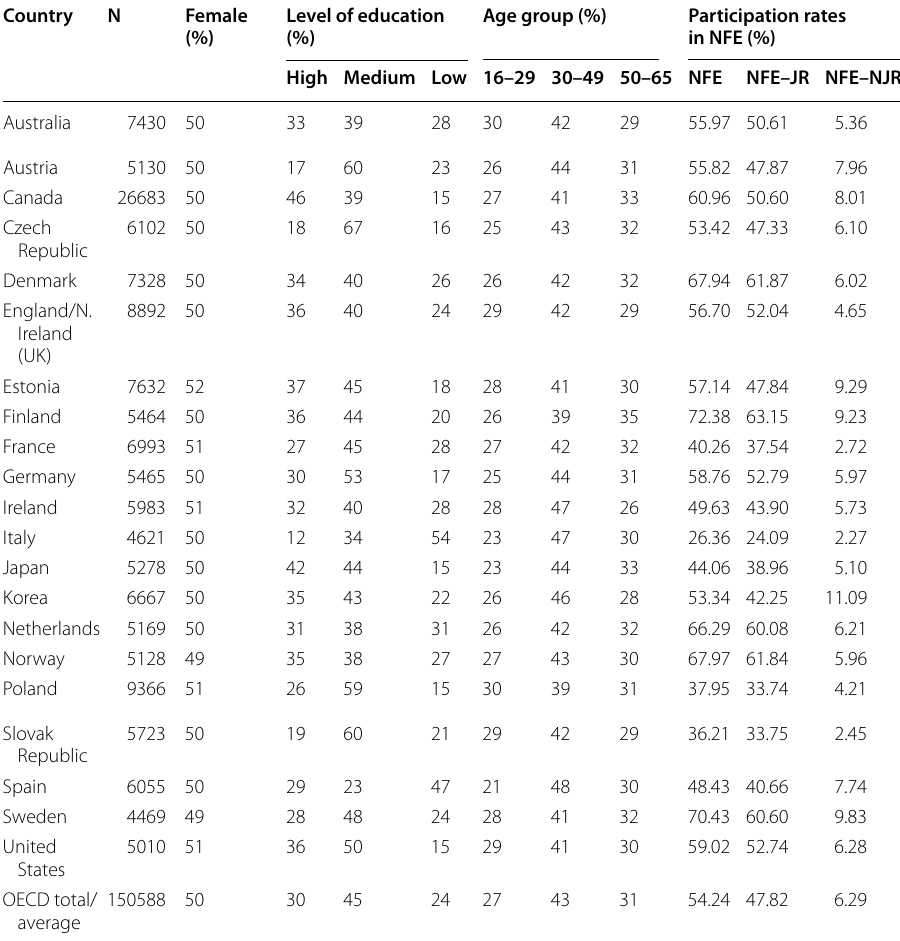
Table 2 Descriptive statistics by countries using sampling